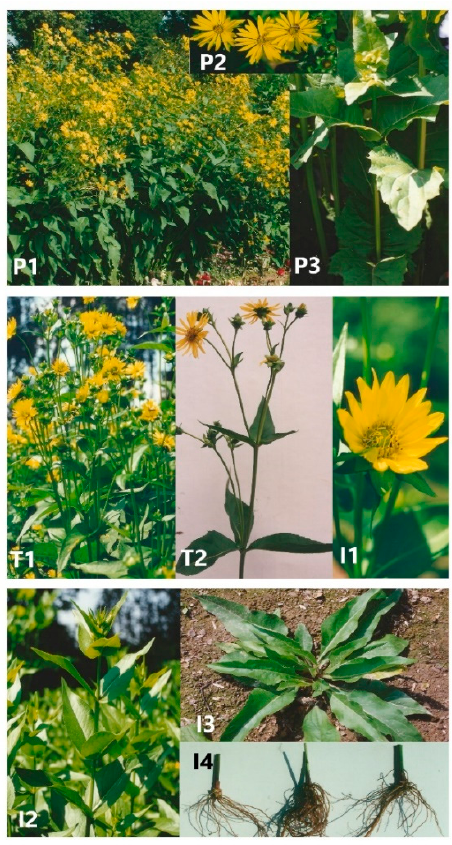
Figure 1. Silphium plants: P- S. perfoliatum (P1—three-year-old plants, P2—inflorescences, P3—shoots) T- S. trifoliatum (T1, T2—shoots), I- S. integrifolim (I1—inflorescences, I2—shoots, I3—one-year-old plants, I4—rhizomes with roots).